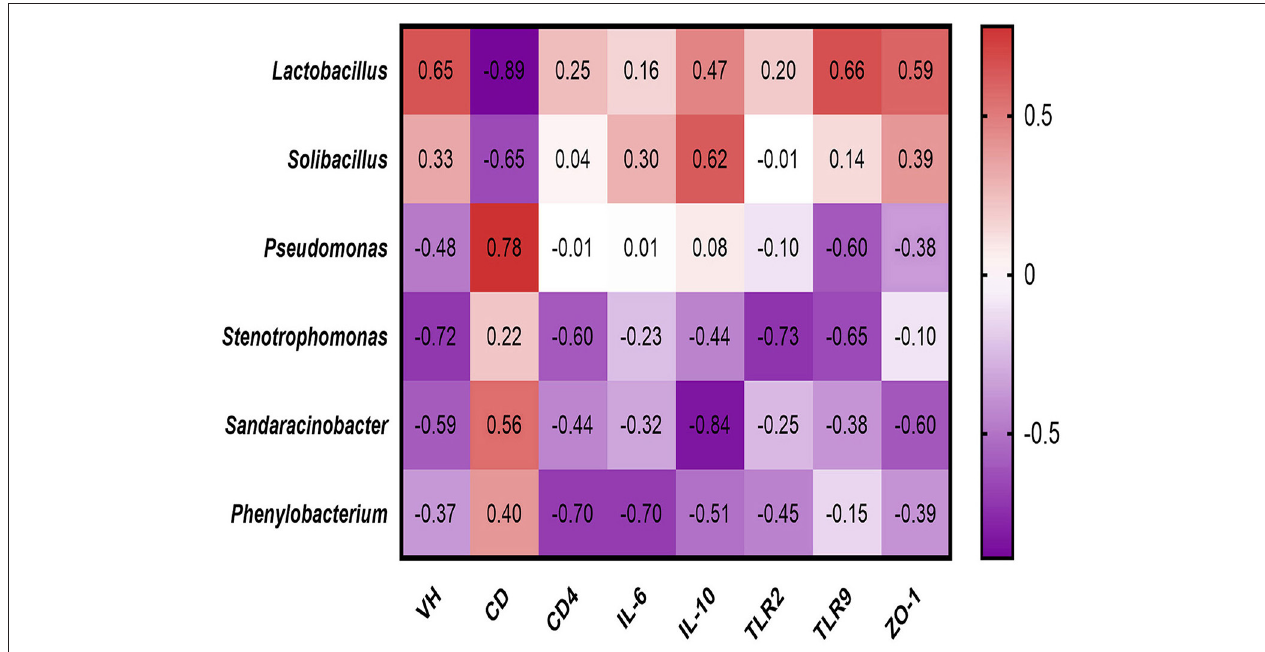
FIGURE 5 | Spearman’s rank correlations between differential jejunal microbiota and immune performance.